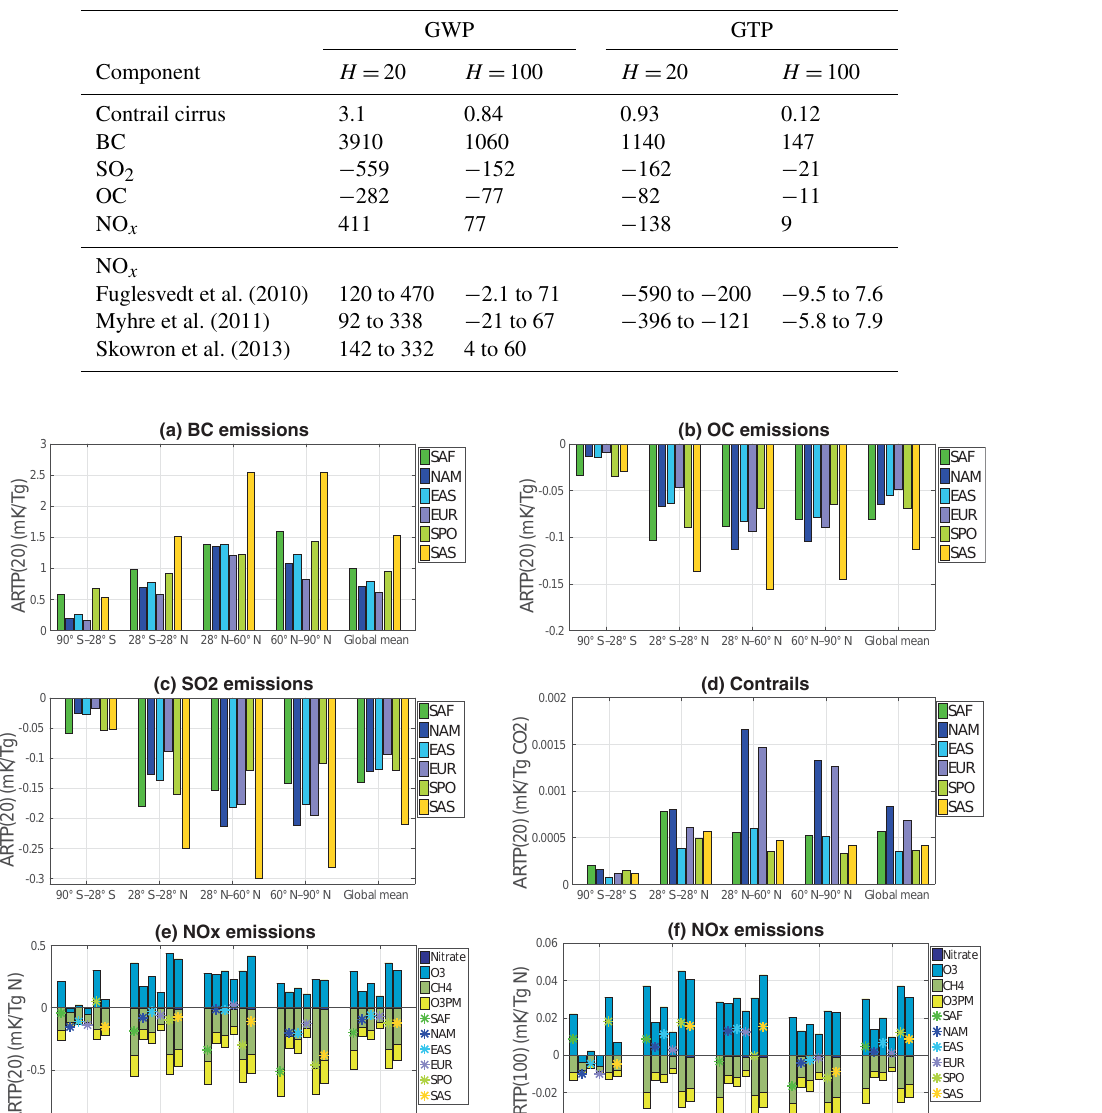
Table 1. GWP and GTP of global aviation emissions for time horizons of 20 and 100 years. Values are given on a per unit aviation emission basis (per kg BC, OC and SO 2 , respectively, with contrail cirrus calculated per kg aviation CO 2 and NO x per kgN). For comparison, aviation NO x GWP and GTP values from three previous studies are also included.